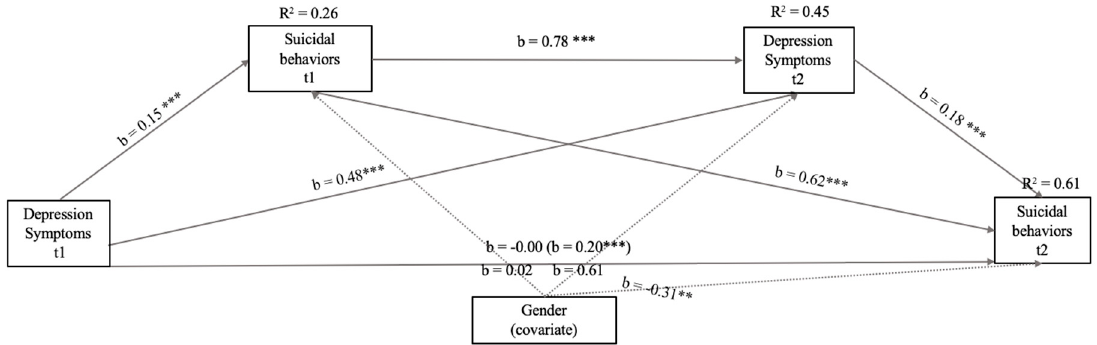
Figure 4. Model of mediation of the relations between Symptoms of Depression (t1 and t2) and Suicide Behaviors (t1) with Suicide Behaviors (t2) after controlling for gender (girl). In this statistical diagram, values are represented with non-standardized regression coefficients. In the association between Depression Symptoms t1 and Suicide Behaviors t2, the value outside parentheses represents the direct effect and the value in parentheses represents the total effect of the bootstrapping analysis of Depression Symptoms t1 on Suicide Behaviors t2 after the inclusion of the mediation variables. *** p < 0.001 ** p < 0.001 * p < 0.05.